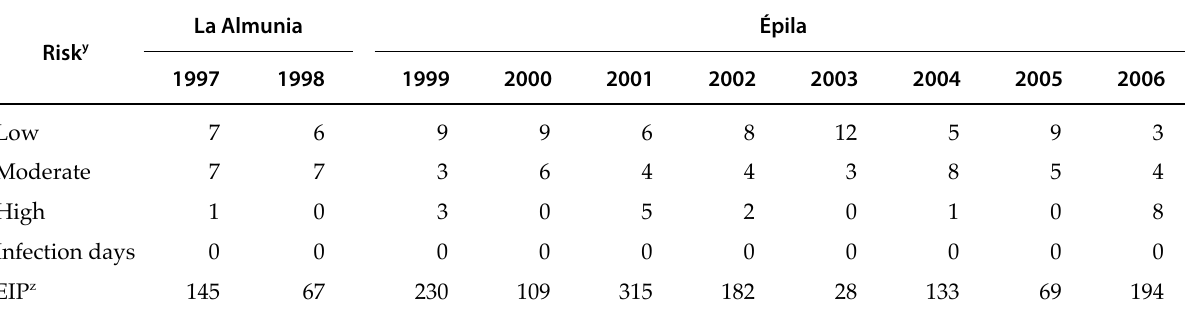
Table 3. Annual variation in number of days with different levels of fire blight risk according to MARYBLYT system dur - ing blooming period in pear cv. Conference, at La Almunia and Épila orchards in Zaragoza (Spain). Epiphytic infection potential is also